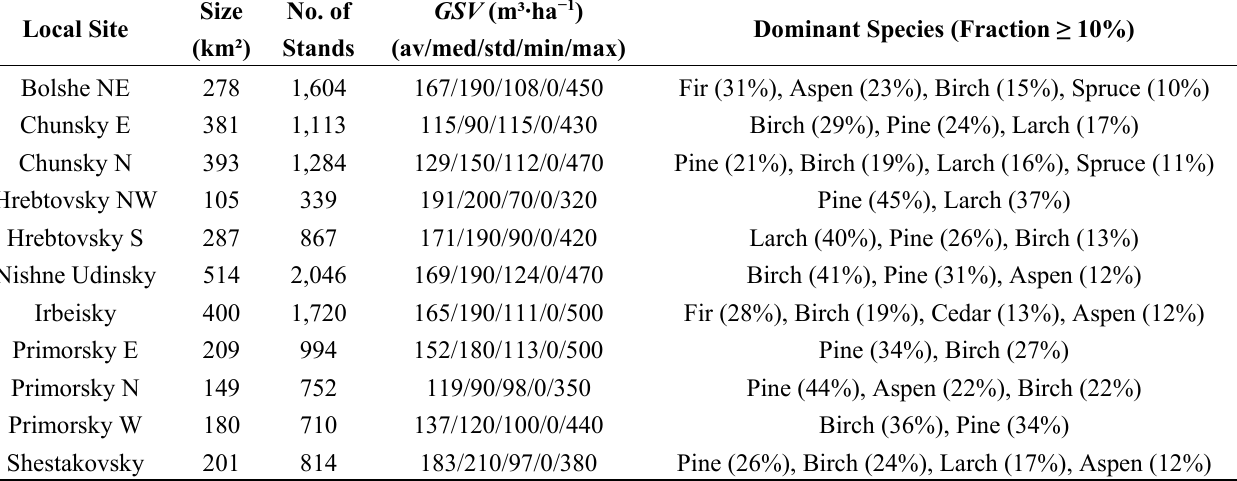
Table 1. Forest characteristics of local sites according to National Forest Inventory (NFI) data (av = average, med = median, std = standard deviation, min = minimum, max =